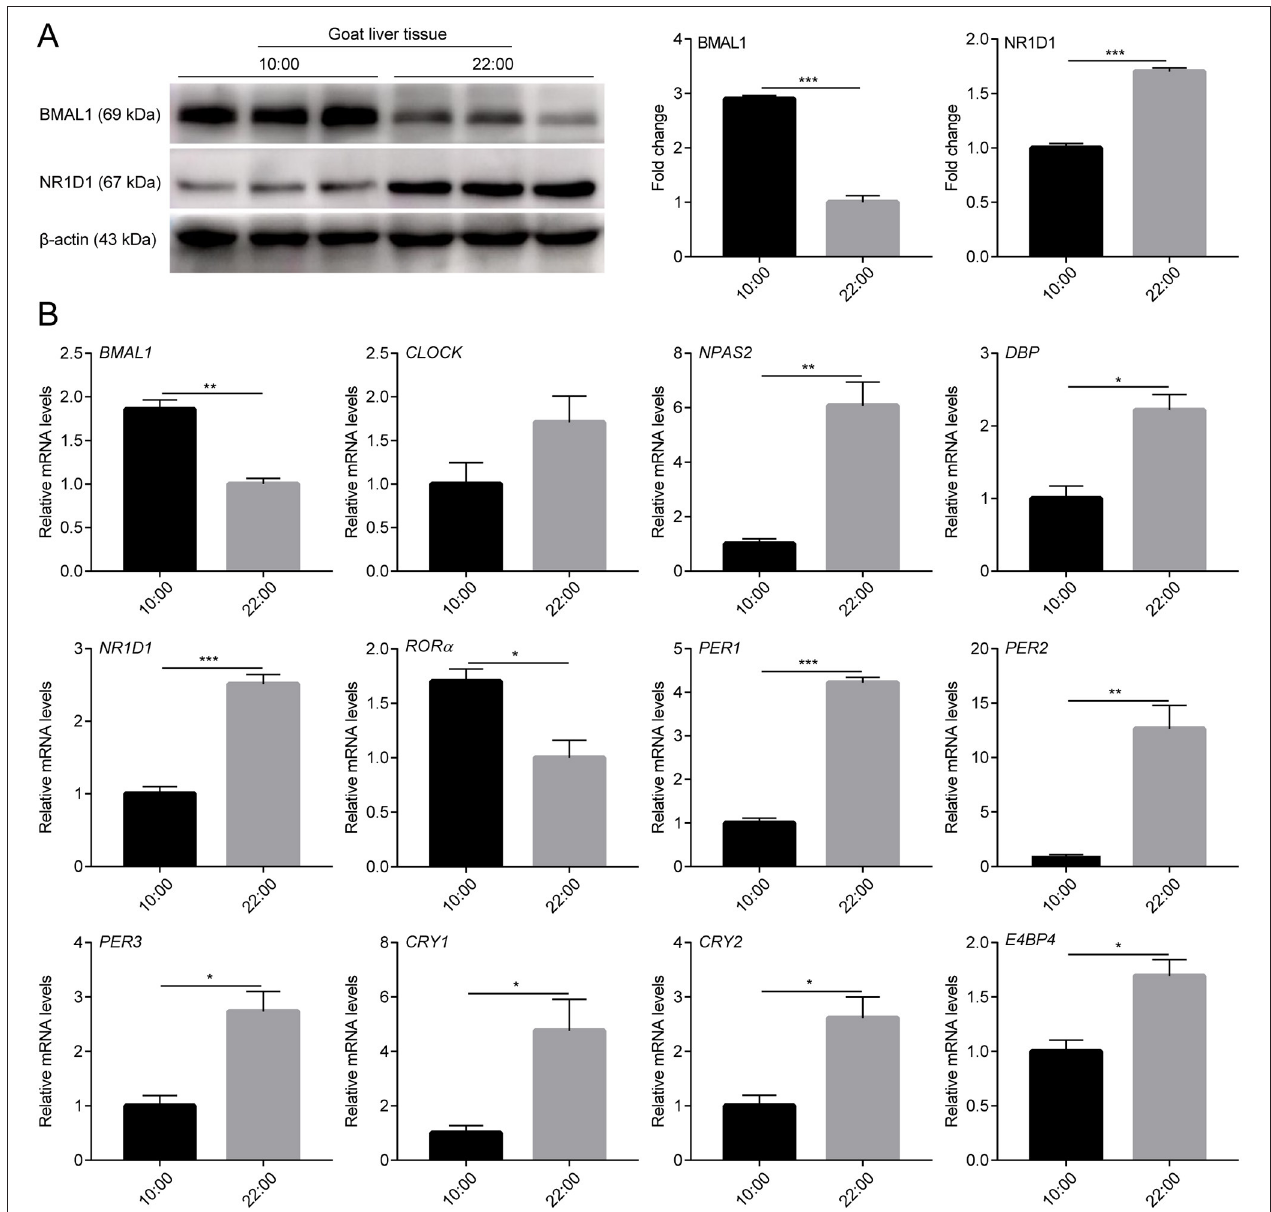
FIGURE 4 | mRNA and protein expression profiles of clock genes in male goat liver tissues. The male goat liver tissues were collected at two representative time points (10:00h and 22:00h). (A) The expression levels of BMAL1 and NR1D1 were examined by western blotting analysis. Representative blots and quantitative analysis from three independent experiments are shown. (B) The mRNA expression levels of clock genes ( BMAL1 , CLOCK , NPAS2 , NR1D1 , ROR α , PER1 , PER2 , PER3 , CRY1 , and CRY2 ) and clock-controlled genes ( DBP and E4BP4 ) were examined by qPCR. All data are presented as means ± SE ( n = 3). Student’s t -test was used to analyze the difference within different groups. Differences were considered significant at P < 0.05. Asterisks indicate significant differences. * P < 0.05, ** P < 0.01, *** P <